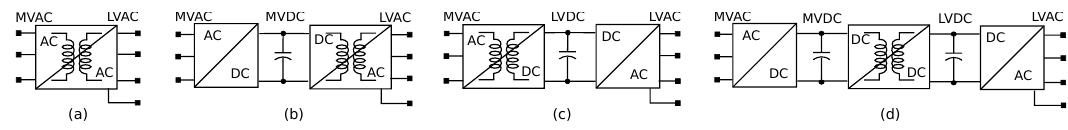
Figure 1. Reported SST Terminology [12,37]: ( a ) single-stage SST; ( b ) two-stage SST with MV DC-link; ( c ) two-stage SST with LV DC-link and ( d ) three-stage SST with MV and LV